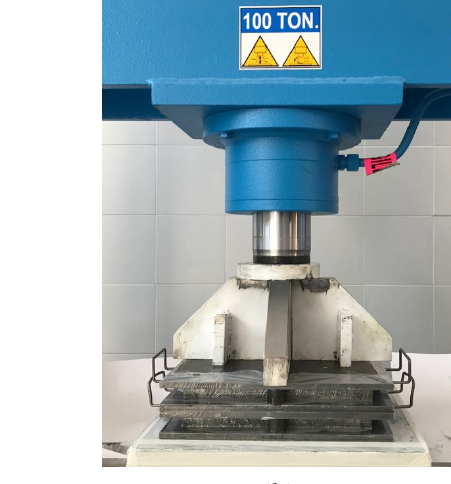
Figure 2. SEM micrographs of the fracture surfaces of the biocomposite subjected to static tensile loading. 2.3. Mechanical Tests The various biocomposite laminates produced were preliminarily characterized by their tensile strength. An MTS 810 servo-hydraulic test machine with a knife edge exten- someter having a 25 mm measuring base was used for the static characterization. The tests were performed in accordance with the ASTM D3039/D standard, in displacement control with an actuator displacement speed of 1 mm/min. Three specimens measuring 25 × 160 mm were tested for each sample. Table 1 shows the experimental results of the tensile tests, in terms of tensile strength, σ R , and Young’s modulus, E , of the biocomposite